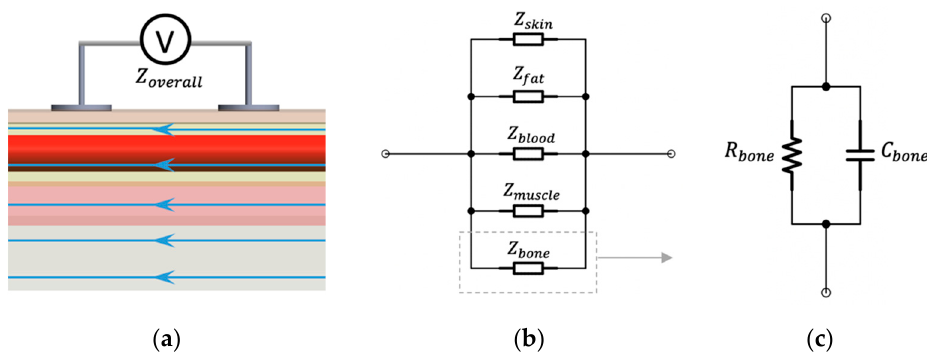
Figure 3. Assumptions for BIM on the wrist: ( a ) ideal parallel current flow; ( b ) equivalent parallel- tissues circuit of measured impedance; ( c ) equivalent parallel RC circuit.